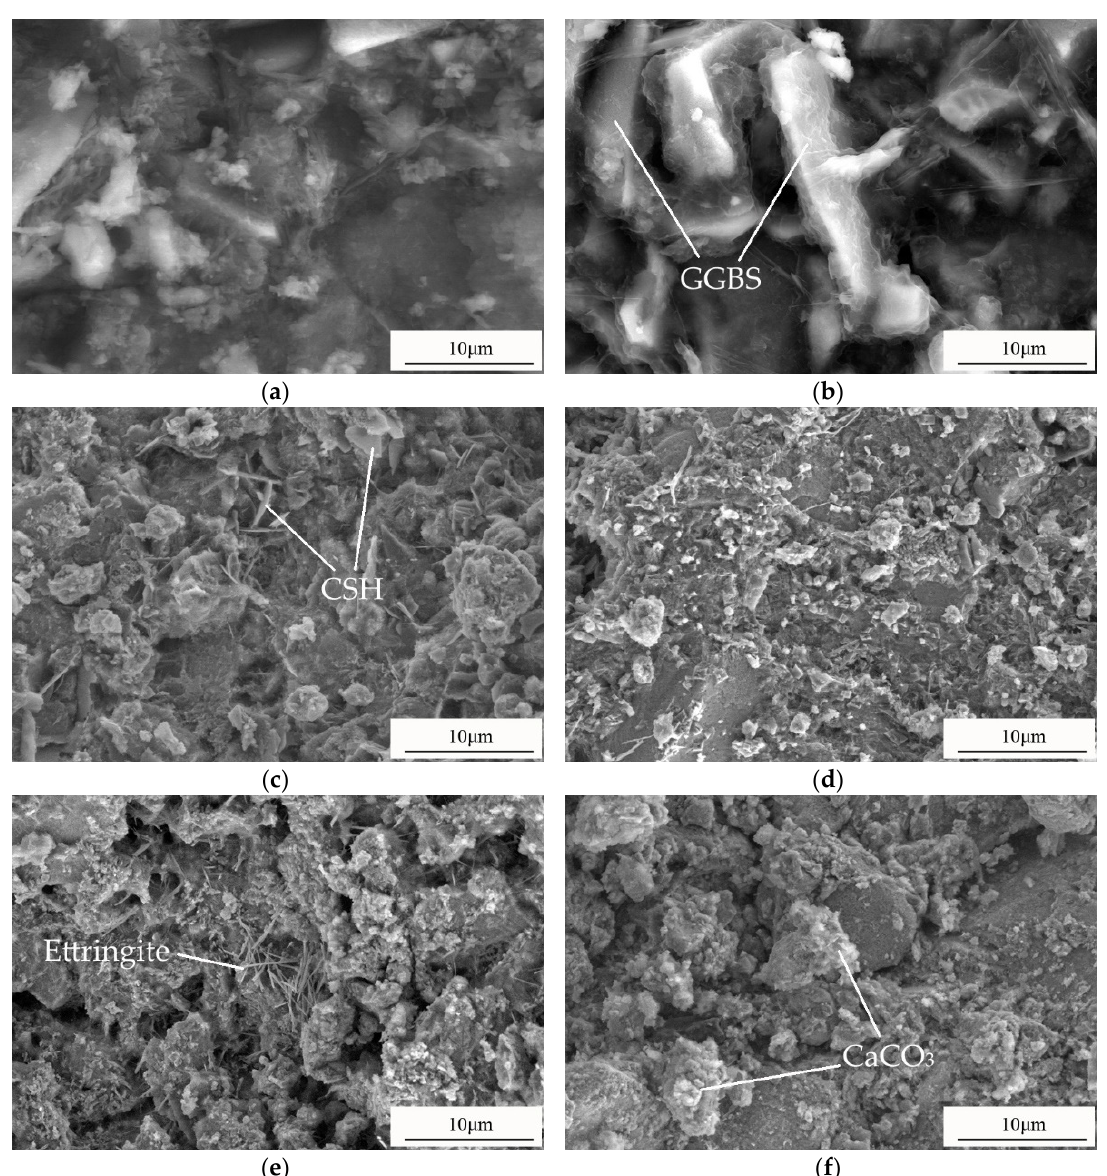
Figure 7. The SEM images of ( a ) S3; ( b ) S5; ( c ) S6; ( d ) S7; ( e ) S8; ( f ) S9.